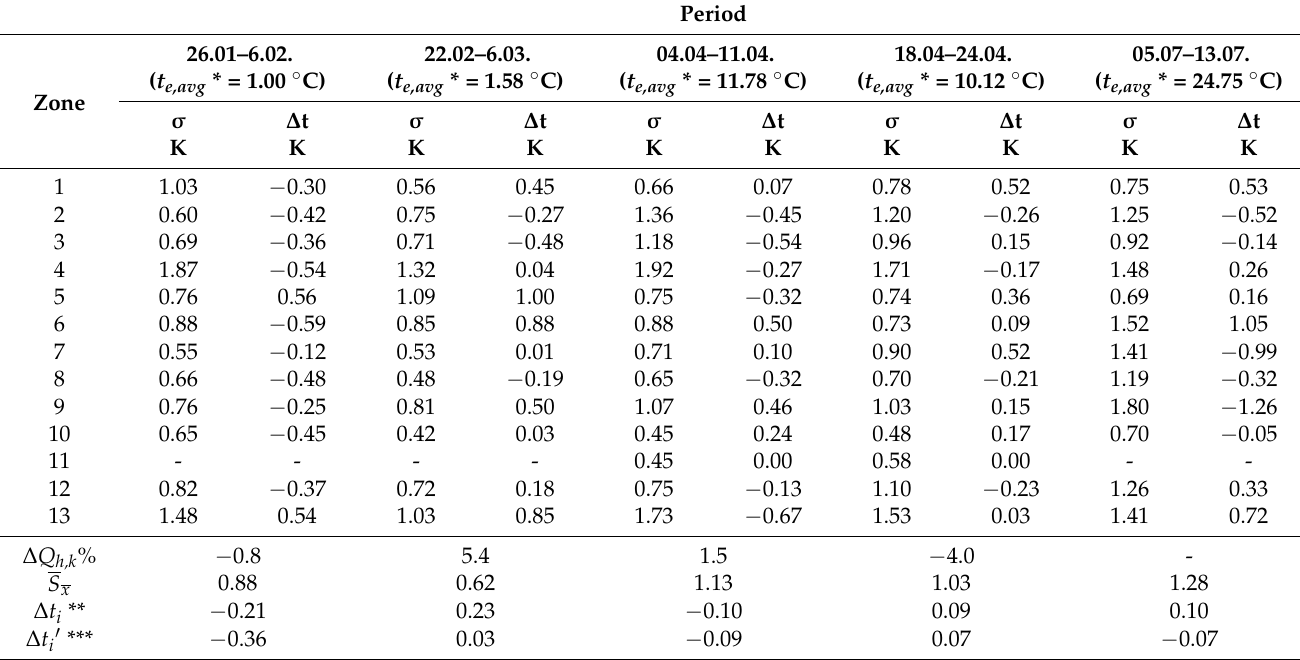
* t e,avg —external average temperature during verification period; ** ∆ t i —average difference between the temperature value obtained from the measurements and the simulation model for all zones; *** ∆ t i (cid:48) —average difference between the temperature value obtained from the measurements and the simulation model for all zones (without zone